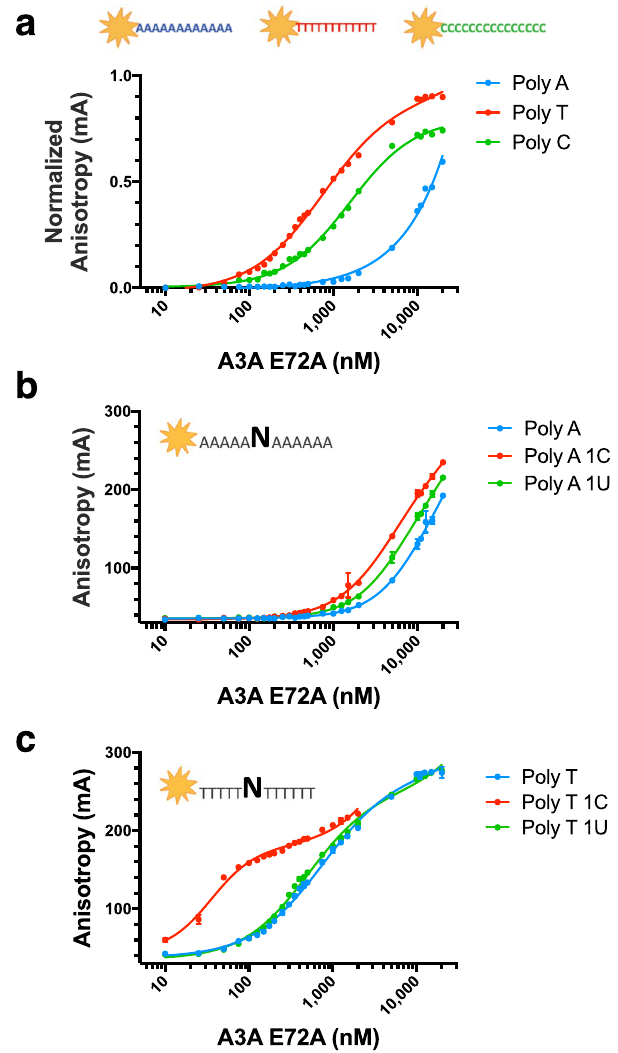
Figure 1. A3A specificity to ssDNA background and substrate. Fluorescence anisotropy of TAMRA-labeled ssDNA sequences binding to A3A(E72A). ( a ) Binding of A3A to poly nucleotide (12 mers): Poly A (blue), Poly T (red) and Poly C (green), ( b ) Binding to Poly A (blue), 5A-C-6A (red), 5A-U-6A (green), ( c) Binding to Poly T (blue), 5T-C-6T (red), 5T-U-6T